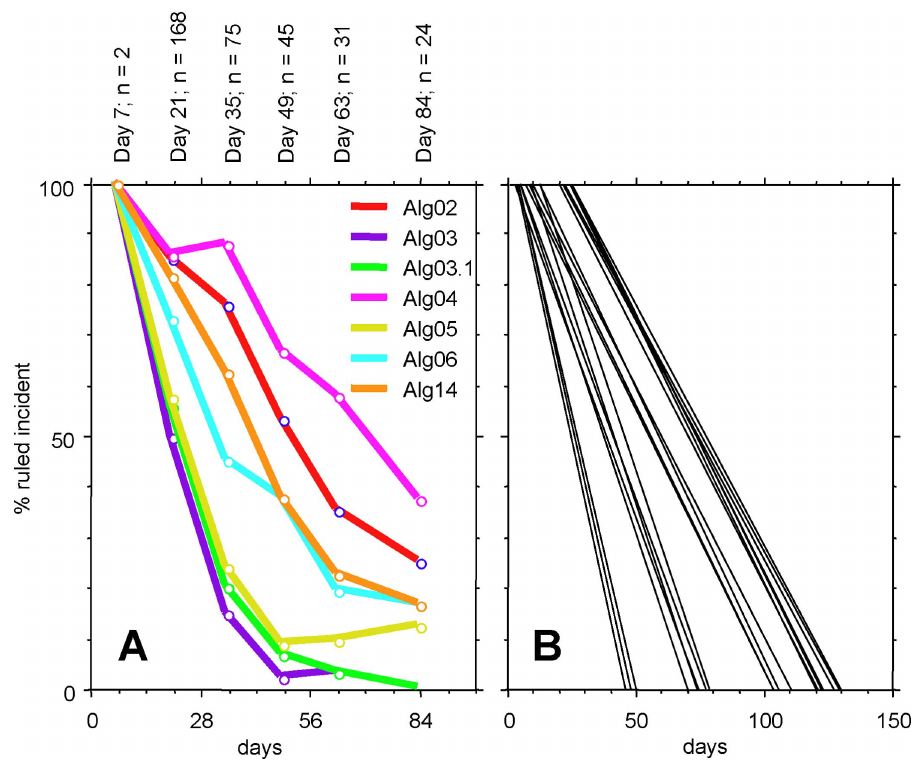
Figure 1. Percentage of cases ruled incident in dependence of time. A. Curves of selected representative algorithms. For algorithm definitions refer to Supporting Information 1. Text on top of the panel denotes the interval midpoints and the number of cases in each interval. B. Linear regression curves of all algorithms except Alg10.